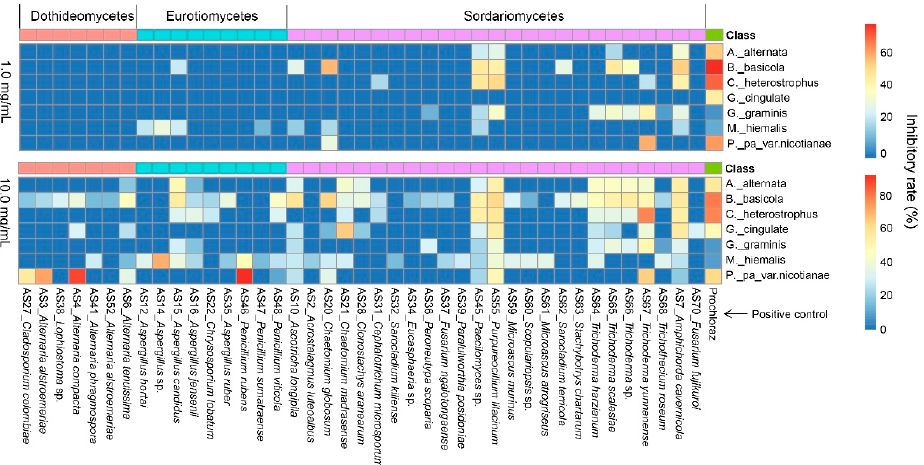
Figure 4. Inhibitory effects of 41 marine-derived fungal strains against seven plant pathogens with Prochloraz as positive control at 1.0 and 10.0 mg/mL concentrations, respectively. Four strains (AS33, AS40, AS50 and AS53) that had no observed effects are excluded.